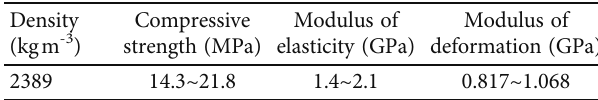
Table 1: Basic mechanical parameters of